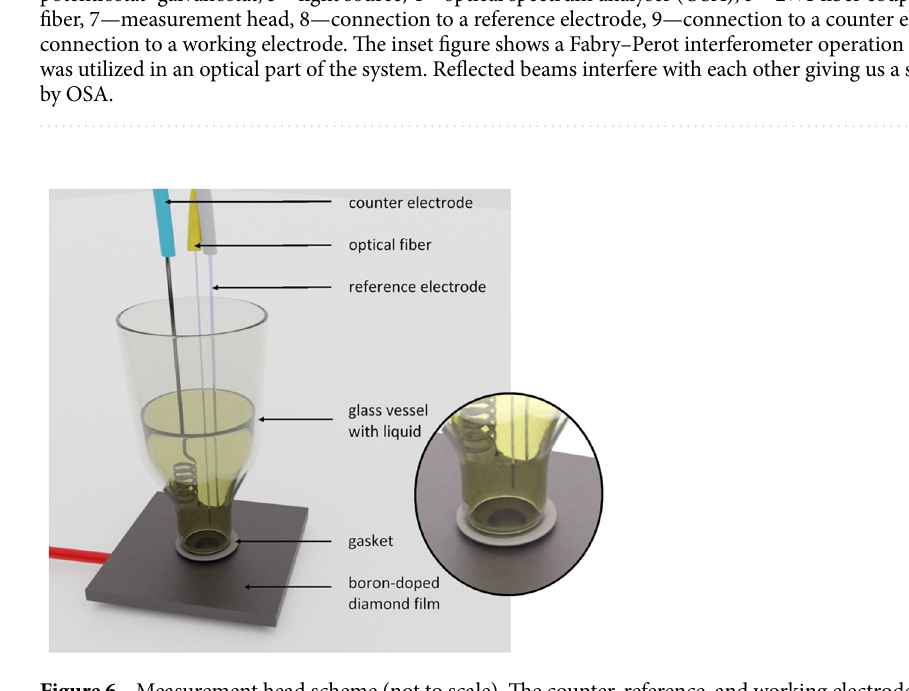
Figure 6. Measurement head scheme (not to scale). The counter, reference, and working electrodes are connected (blue, white, red wire, respectively) to the potentiostat–galvanostat, creating the electrochemical part of the measurement head. The optical fiber (yellow wire) is placed together with the electrodes in the glass vessel. The fiber and the boron-doped diamond film constitute the Fabry–Perot interferometer inside the electrochemical cell, with the cavity fulfilled by the investigated liquid. Close-up shows placement of the connections: all end above the BDD, they do not touch each other, and the optical fiber end-face is perpendicular to the